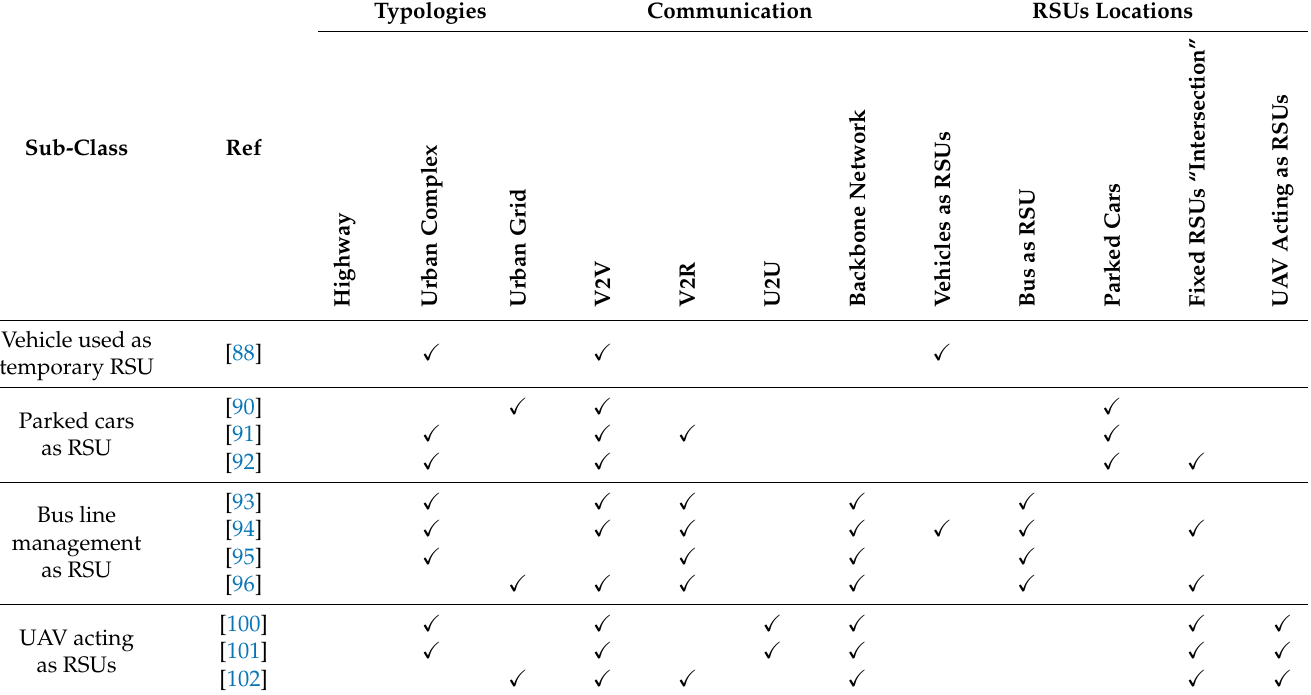
Table 3. Comparison between the various dynamic deployment